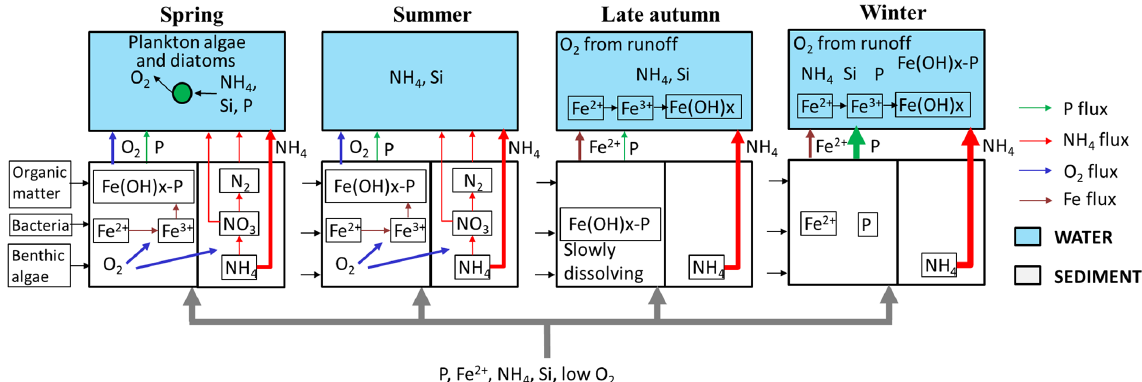
Figure 7. Schematic representation of N and P dynamics in spring, summer, later autumn and winter. The thickness of the flow lines represents the concentration magnitudes, the thicker the line, the higher the